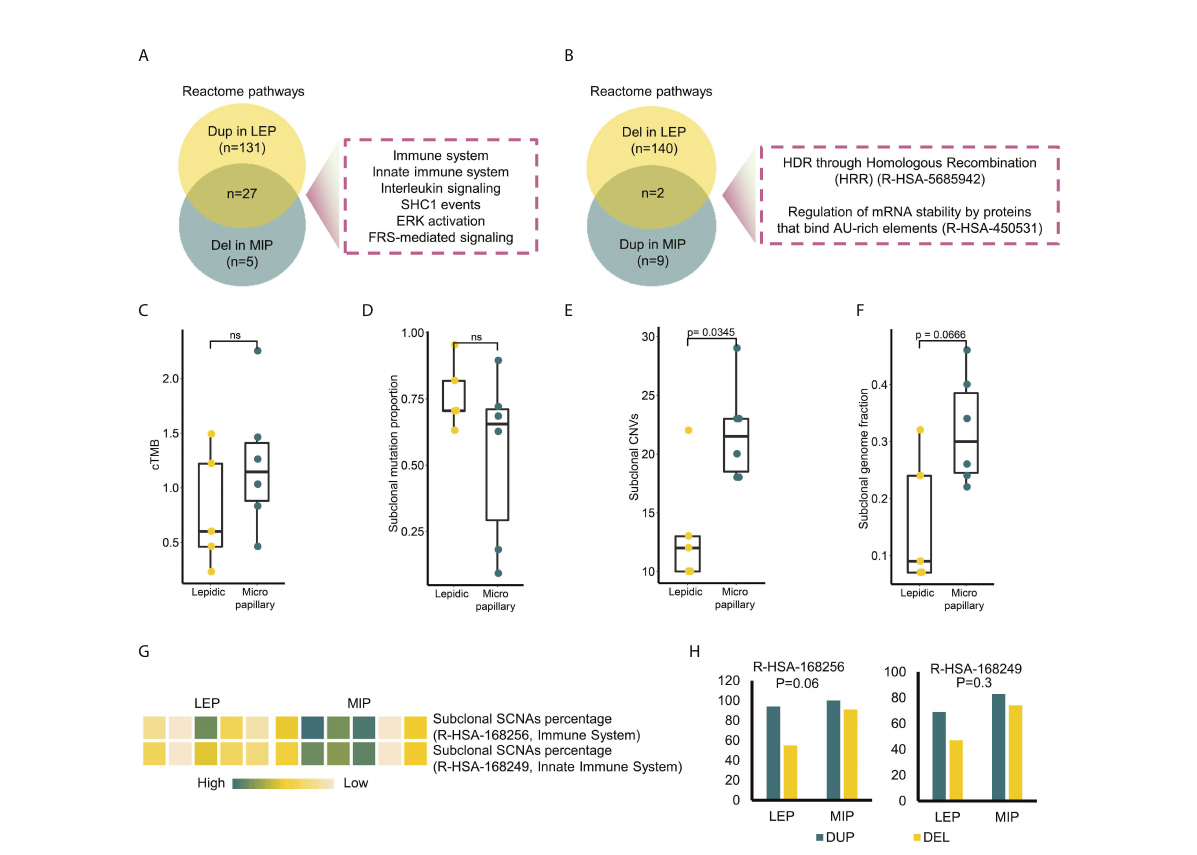
FIGURE 2 Multi-perspective investigation on intratumor heterogeneity (ITH) difference between two subtypes. (A) Intersection of the enriched pathways in genes uniquely ampli fi ed in LEP and deleted in MIP. (B) Intersection of the enriched pathways in genes uniquely deleted in LEP and ampli fi ed in MIP. (C – F) Clonal tumor mutation burden (cTMB), subclonal mutation proportion, subclonal CNV and subclonal genome fraction distribution in two subtypes. (G) Subclonal SCNA percentage of two Reactome immune pathways in sequenced samples. (H) Focal alternation number on